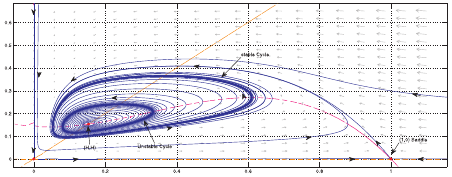
Figure 7. For A = 0 . 1 , B = 0 . 02 , S = 0 . 01 and Q = 0 . 7 , the positive equilibrium point is a weak focus of order two, surrounded by two limit cycles, the innermost unstable and the outermost stable and (1 , 0) is a hyperbolic saddle.